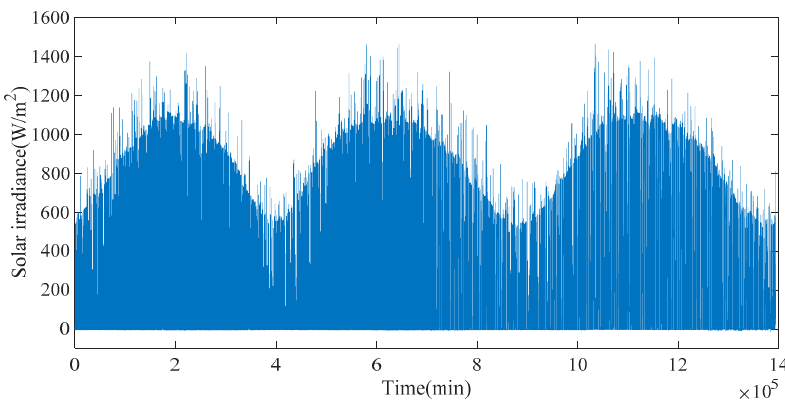
Figure 7. Solar irradiance data of Desert Rock station from 2014 to 2016.